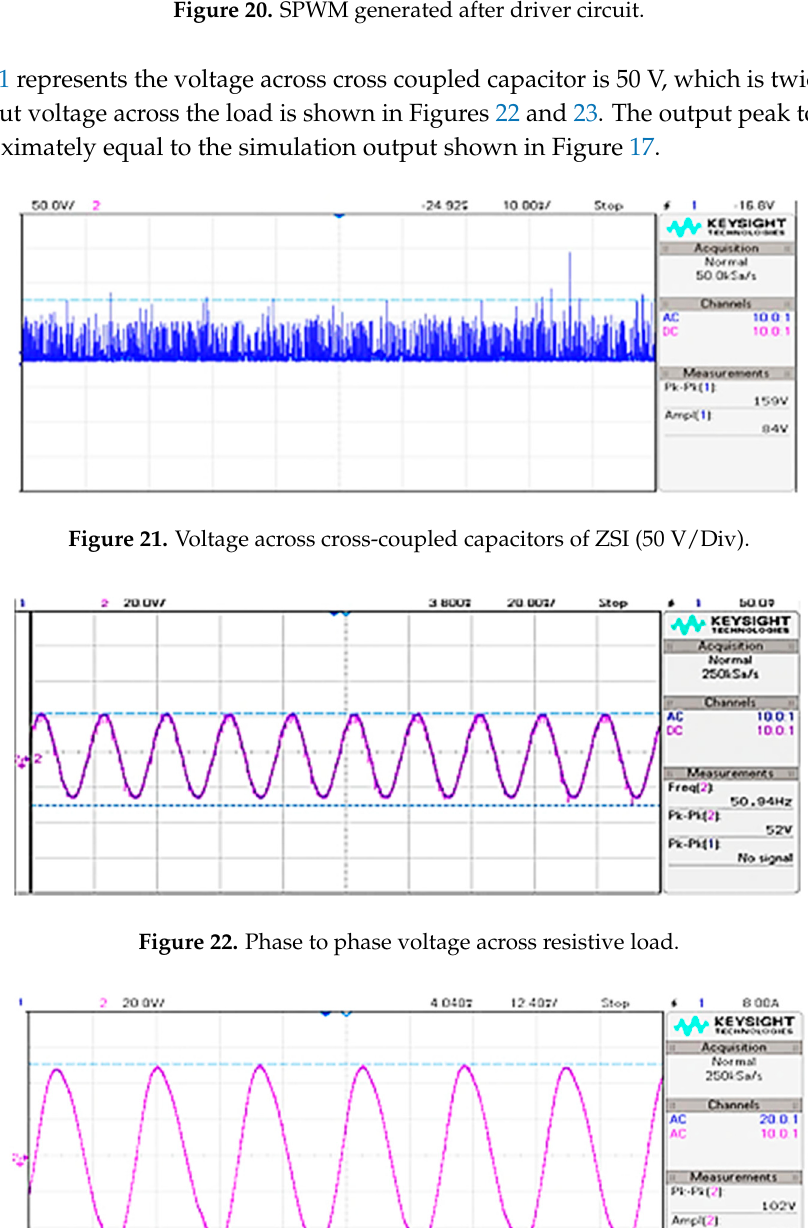
Figure 20. SPWM generated after driver circuit.